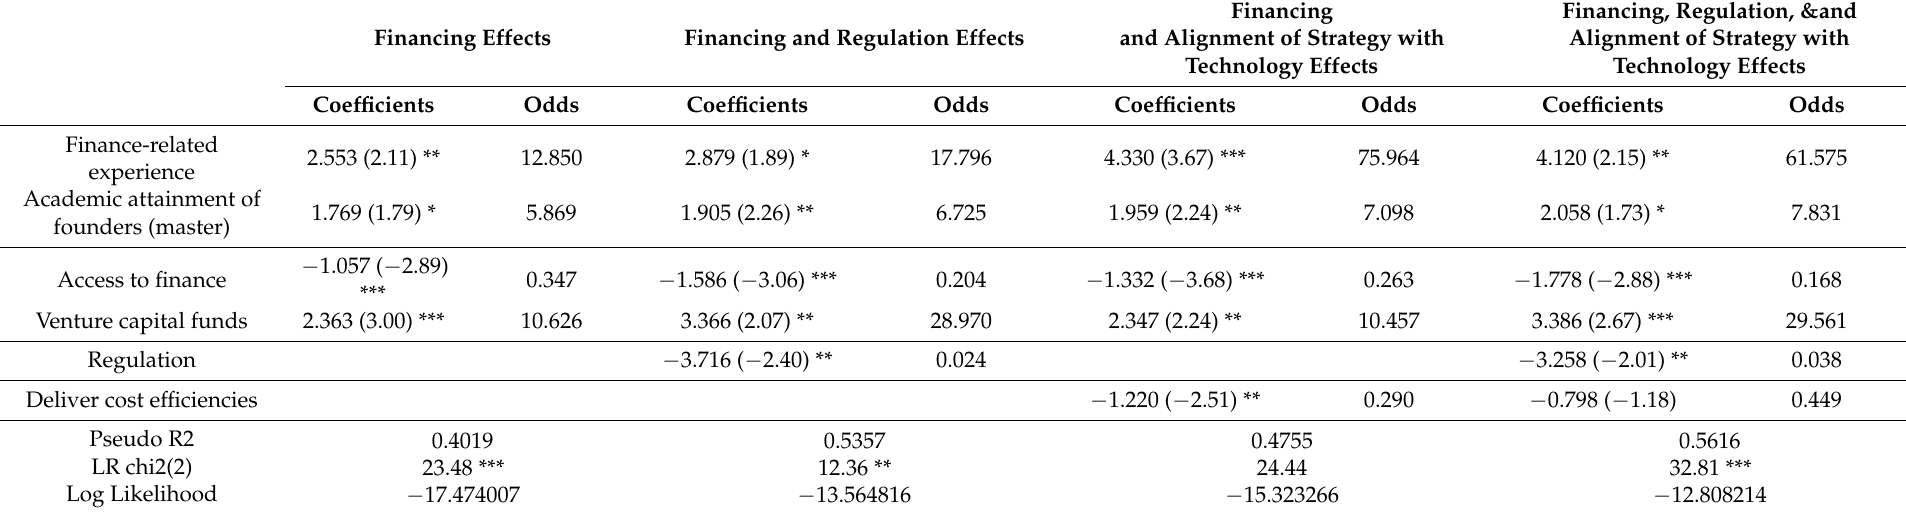
Table 2. Excerpt from the OL regression analysis showing the significant financing, regulation, and alignment of strategy with technology factors affecting FinTechs’